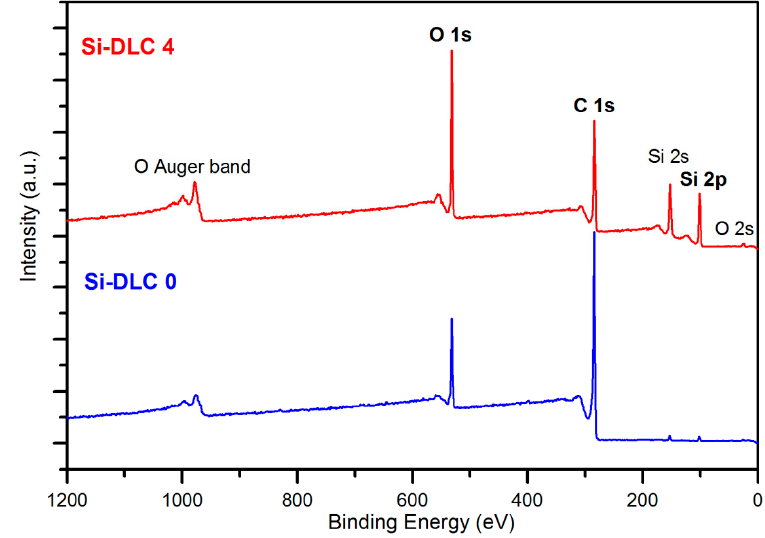
Figure 2. The X-ray photoelectron spectroscopy (XPS) wide scans of the surface of the Si-DLC 0 and Si-DLC 4 samples.